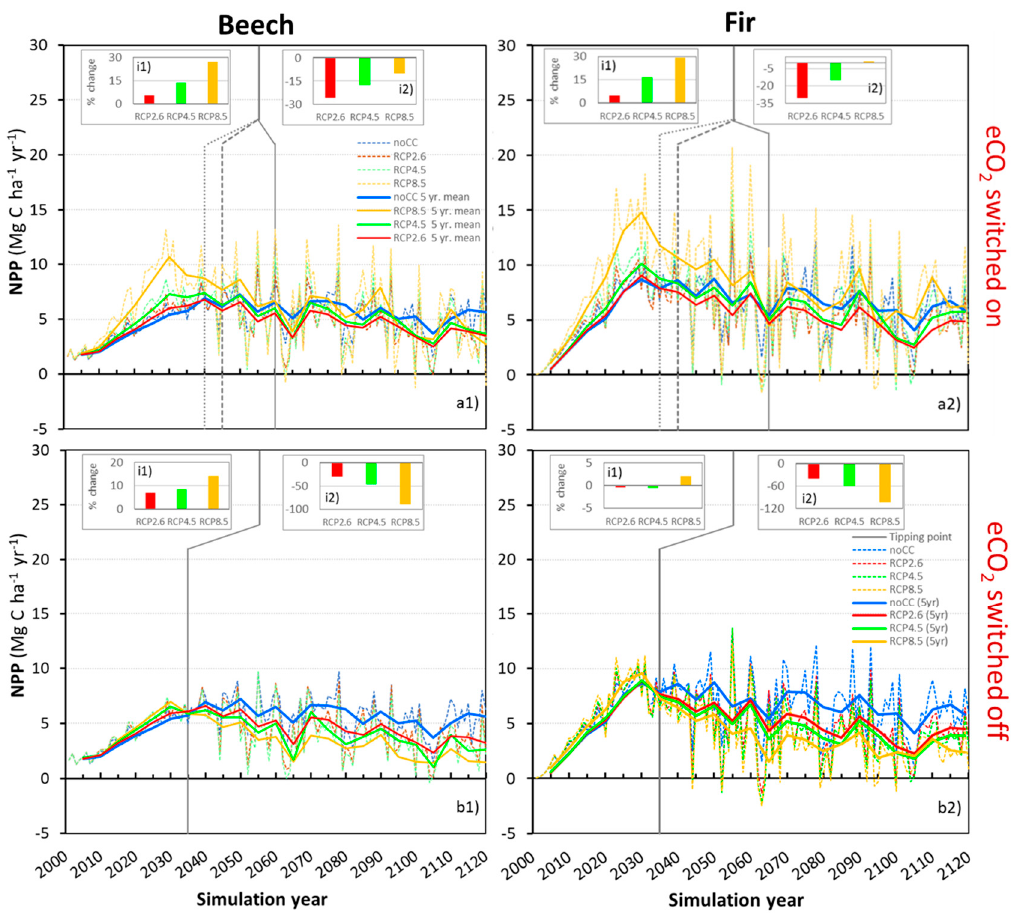
Figure 4. Effects of four climate scenarios (no climate change (noCC), representative concentration pathway 2.6 (RCP2.6), RCP4.5, RCP8.5) on net primary productivity (NPP) of beech (left) and fir (right) with eCO 2 ( a1 , a2 ) and with eCO 2 switched o ff ( b1 , b2 ). Solid lines represent the running average of 5 years. Vertical dotted, dashed and solid lines indicate the tipping points when the NPPs of the RCP scenarios fall below the reference scenario noCC. Inset plots show the differences of NPP in percent compared to noCC before and after such tipping points (i1 and i2). Simulations started with naturally regenerated juvenile stands.